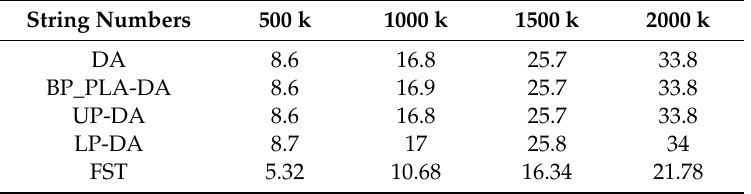
Table 5. SynthDS storage spaces